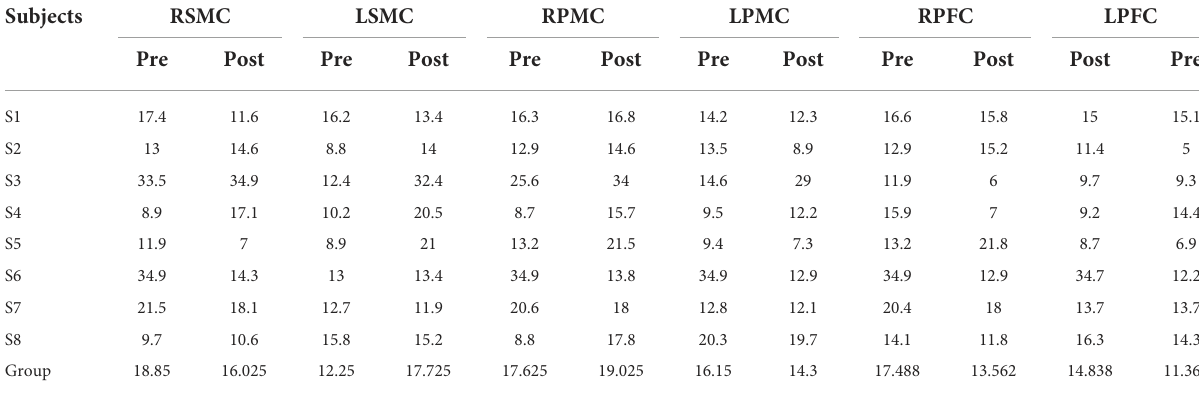
TABLE 6 The average individual and group Latency (s) of all the subjects on 6 ROI pre and post intervention during grip-release ring task.